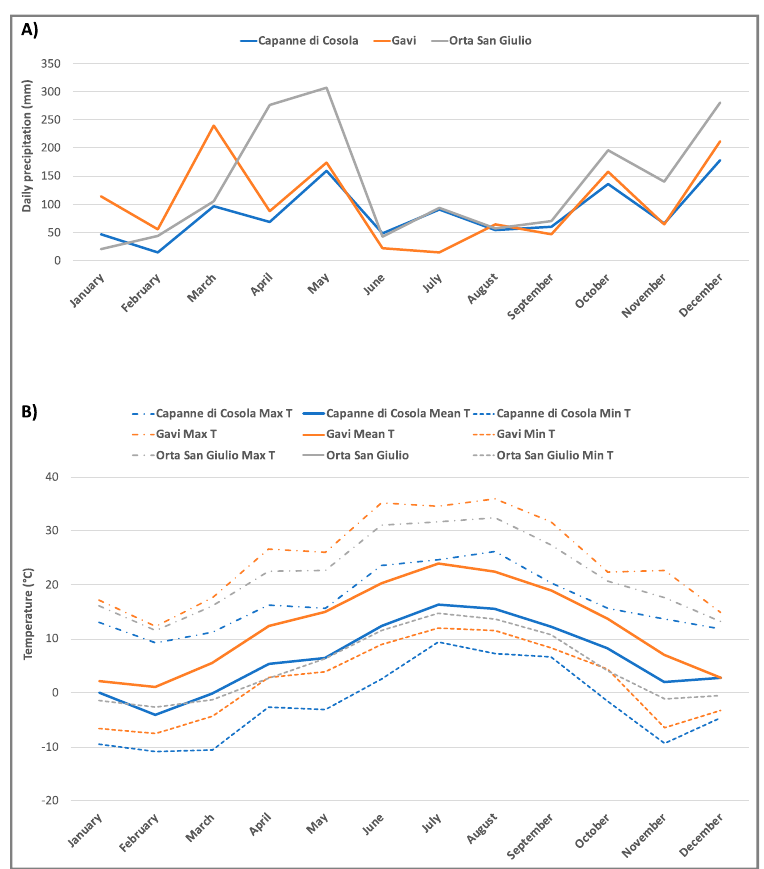
Figure 2. Climatic data for the three sampling sites (Capanne di Cosola, Gavi, Orta San Giulio). ( A ) Daily mean precipitation (mm); ( B ) temperature (T) (mean temperature, minimum temperature and maximum temperature) (°C).